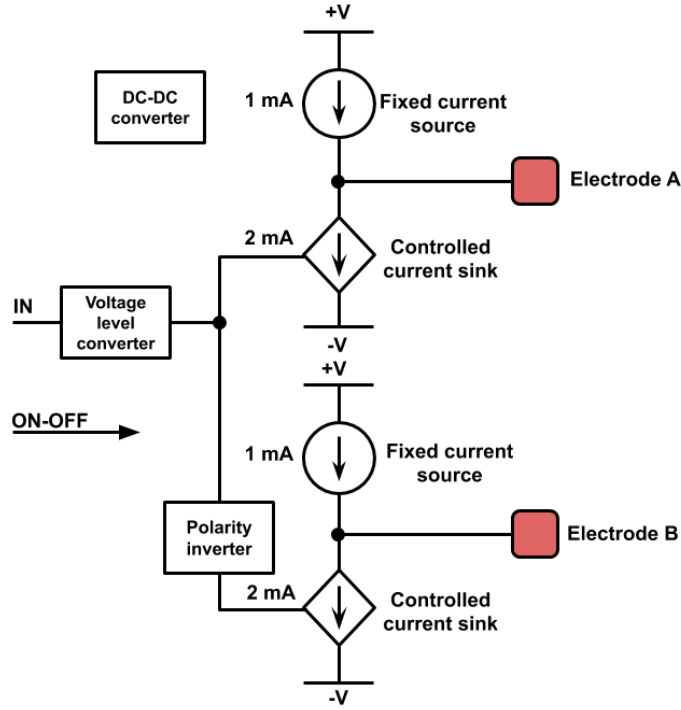
Figure 1. Differential current driver block. Data bits written at the inputs (IN and ON-OFF) converted into current pulses at the electrodes A and B.